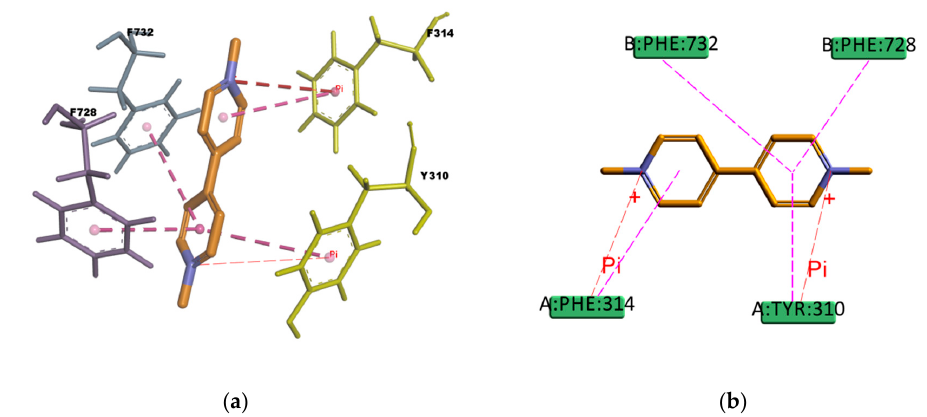
Figure 19. Paraquat (PQ) top-ranked pose obtained with CDOCKER algorithm. ( a ) 3D view of PQ interactions in the binding pocket. The pink dotted lines represent π – π T-shaped interactions, and the red dotted lines represents cation– π interactions. Residues F314 and Y310 involved in the cation– π interactions are highlighted in yellow; ( b ) 2D interaction diagram of PQ with h P-gp interacting residues. The pink dotted lines represent π T-shaped interactions, and the red dotted lines represent cation– π interactions with residues F314 and Y310.